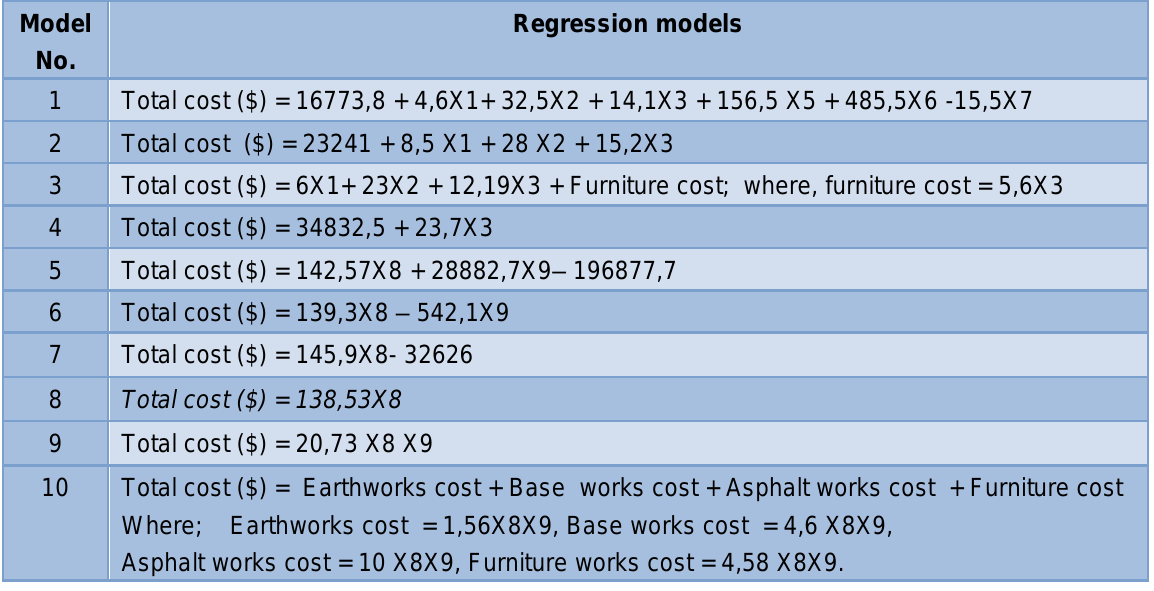
Table19 Summary of the developed regression